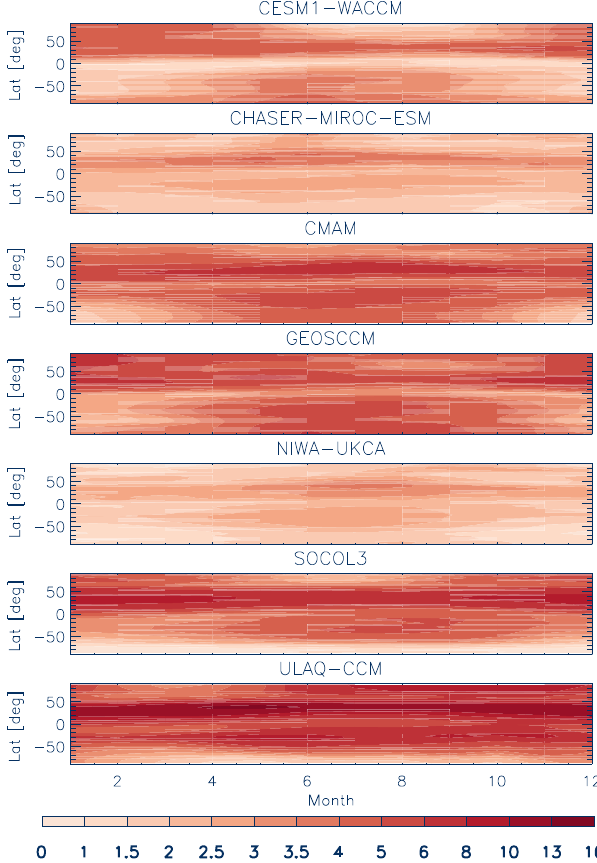
Figure 3. Ratio of zonal-mean surface ozone changes to changes in surface CH 4 (in ppbvppmv − 1 ) as derived from the REF-C2 and SEN-C2-fCH4